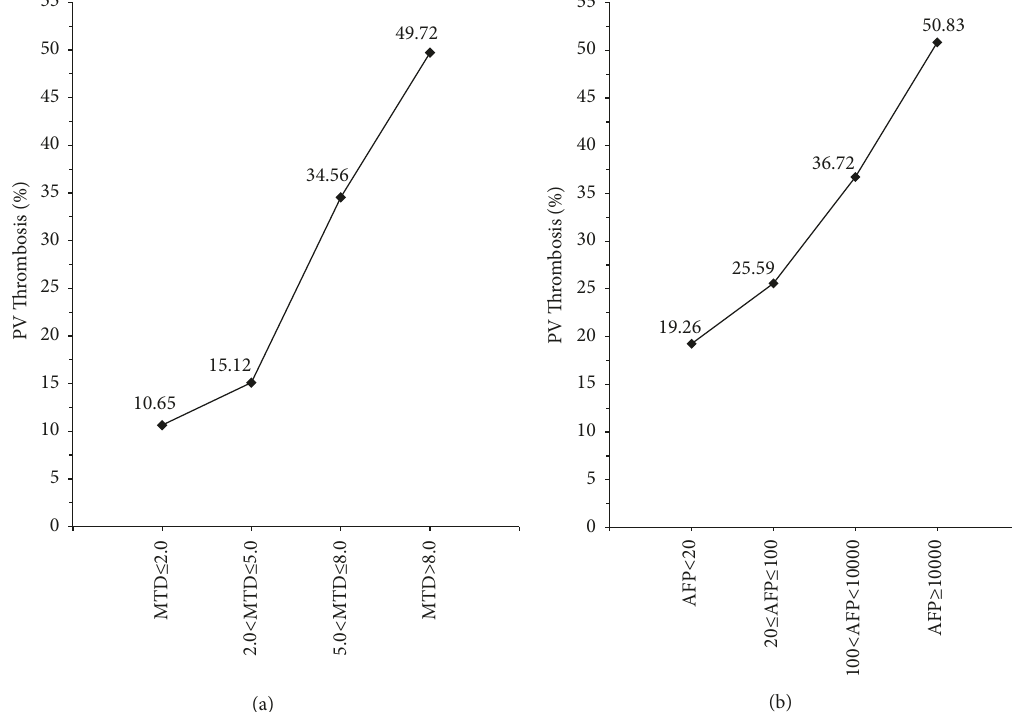
Figure 1: Percentage of patients with PV Thrombosis in (a) MTD (cm) categories, in total cohort (p < 0.0001 ∗ ) ; (b) AFP (IU/mL) categories (p < 0.0001 ∗ ) ; ∗ Chi-square test for trend; PVT, portal vein thrombosis; MTD, maximum tumor dimension; AFP,